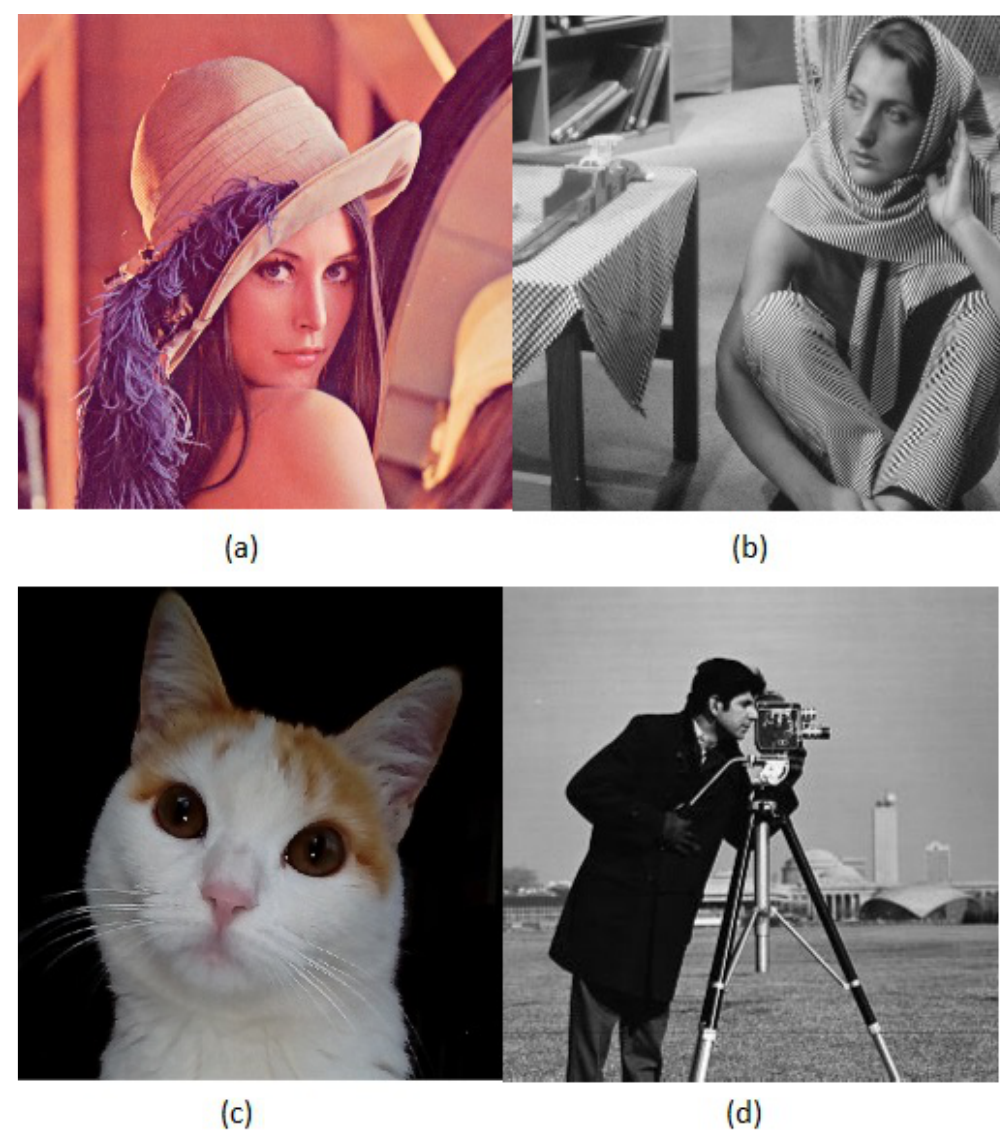
Figure 1. Images used for evaluating ICLEBF: ( a ) Lena, ( b ) Barbara, ( c ) Vicky, ( d )